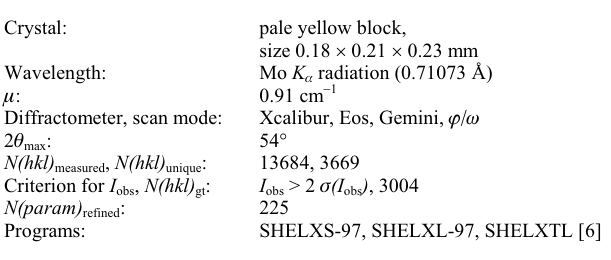
Table 1. Data collection and handling.